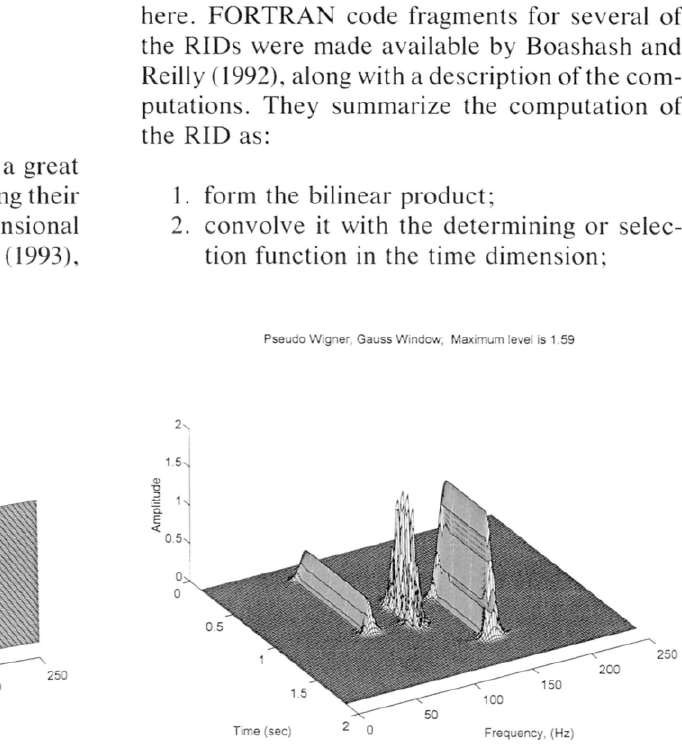
FIGURE 2 Short time Fourier transform of Twosines.